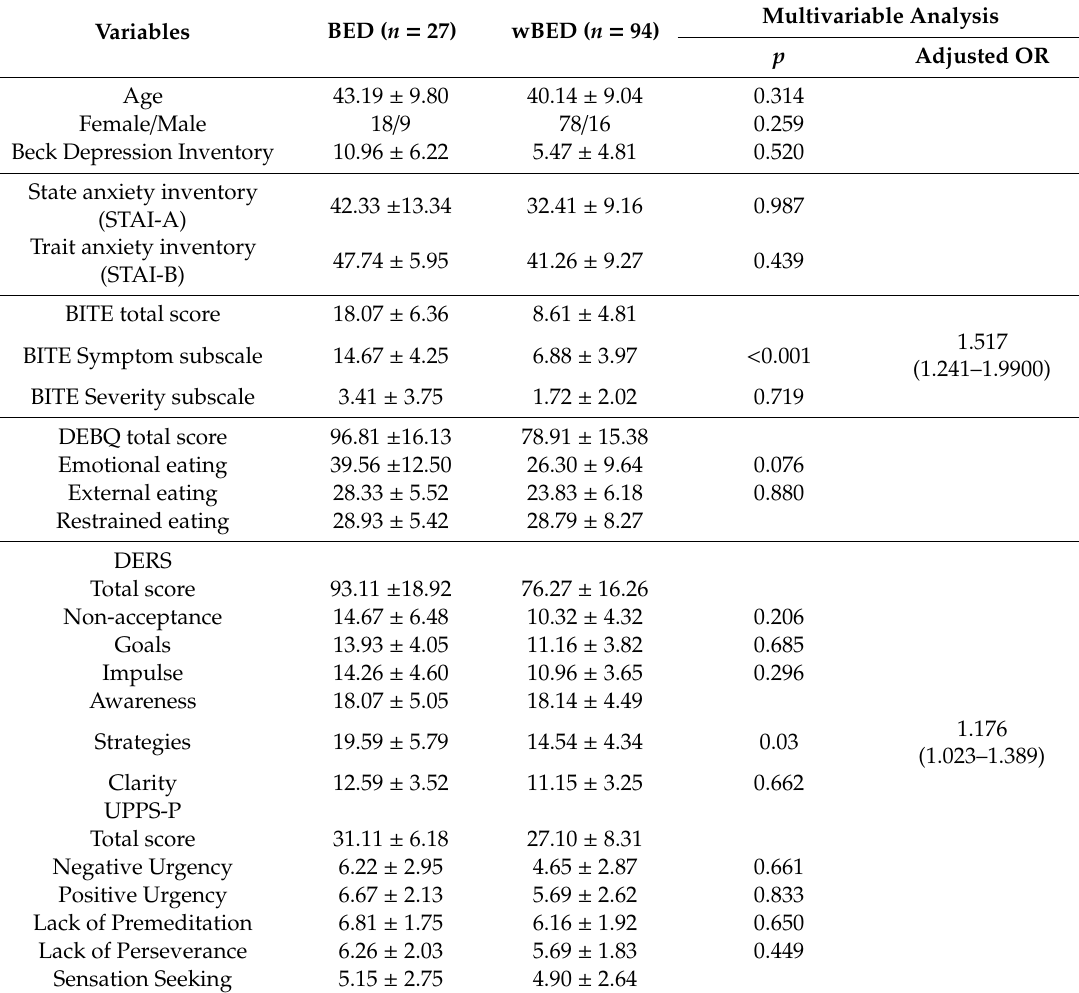
Table 2. Comparison of sociodemographic and clinical characteristics in obese adults seeking bariatric surgery using multivariable analyses (with binge eating disorder (BED) and without BED